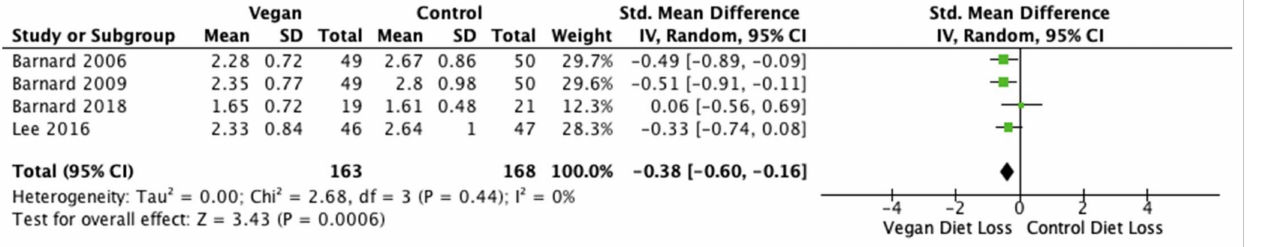
Figure 7. Forest plot showing mean LDL cholesterol after consumption of low-fat vegan and control diets [28,40,46,47].